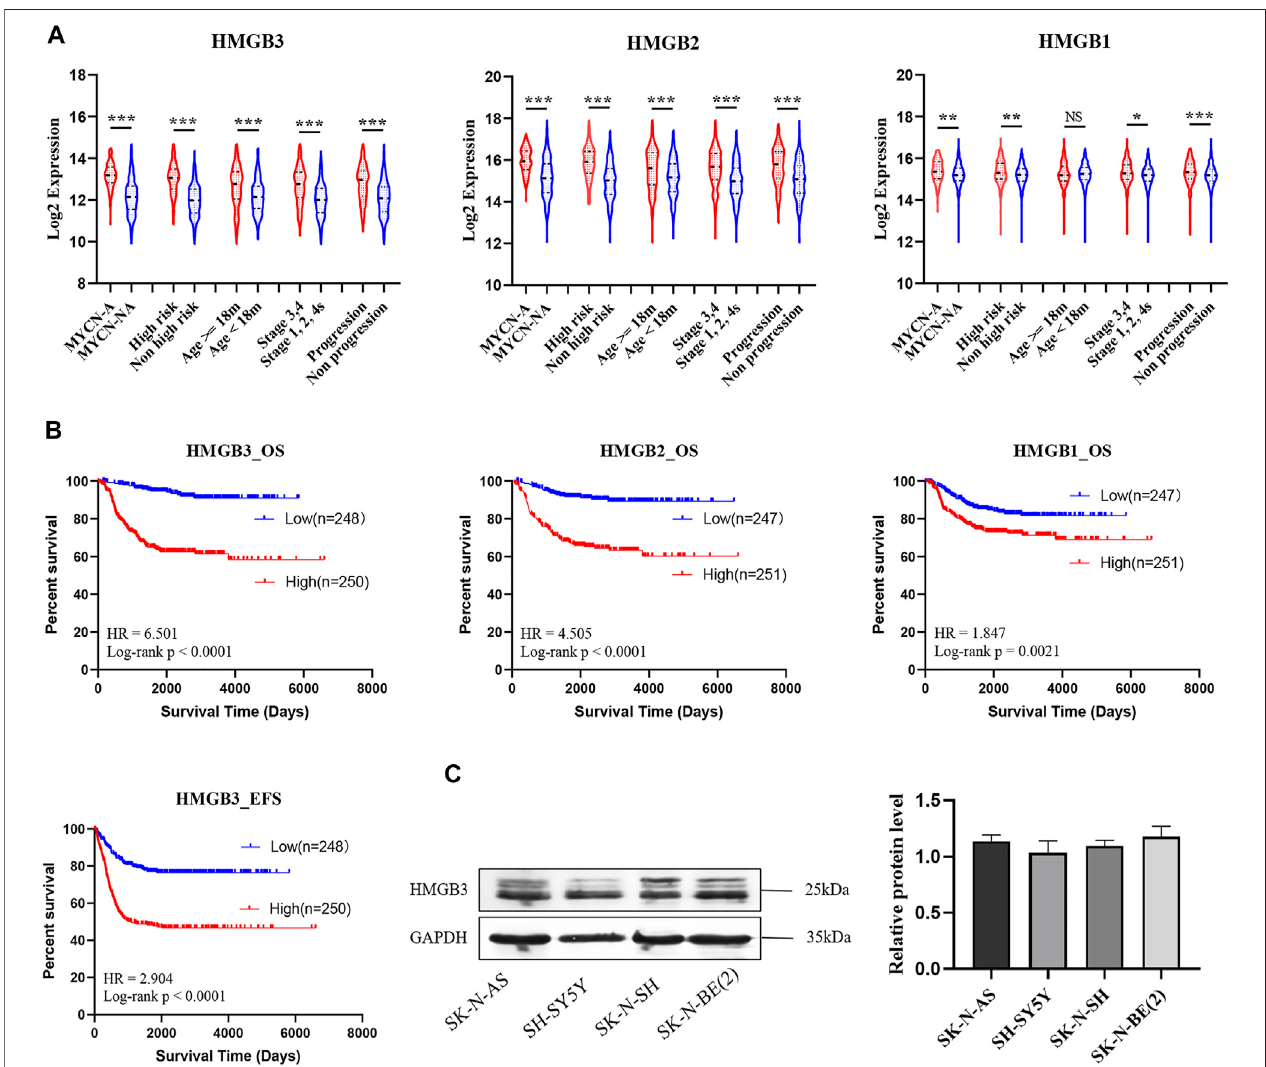
FIGURE1| HMGB3isabnormalhighlyexpressed inhumanneuroblastomawithunfavorableprognosesinGSE49710. (A) HMGB3over-expressedinunfavorable prognostic groups of NB patients. (B) High expression of HMGB3 correlated to inferior overall survival. (C) Expression of HMGB3 in four NB cell lines. * p < 0.05, ** p < 0.01, and *** p <